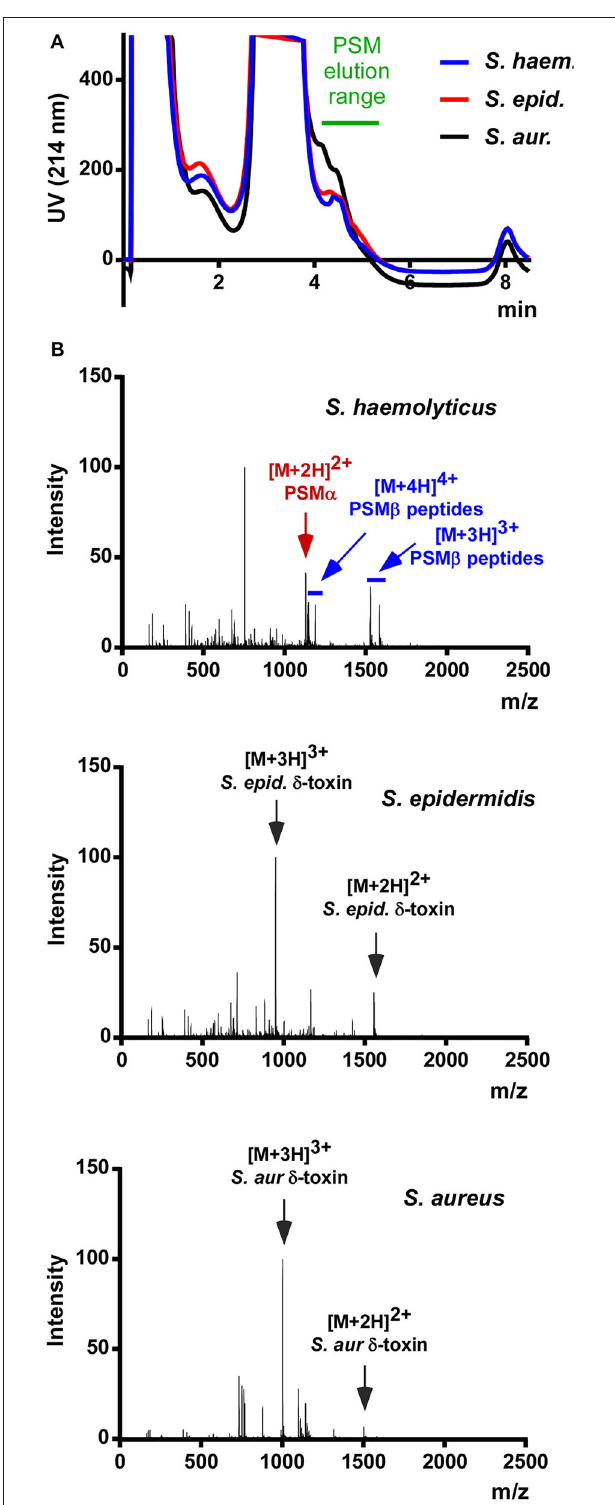
FIGURE 1 | RP-HPLC/MS of S. haemolyticus culture filtrate in comparison with S. aureus and S. epidermidis . (A) Stationary-phase culture filtrates of S. haemolyticus , S. epidermidis , and S. aureus were